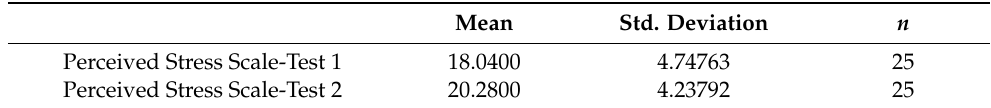
Table 6. Mean results for Perceived Stress Scale for the ANCOVA model for Group II pre-test and post-test measurements.